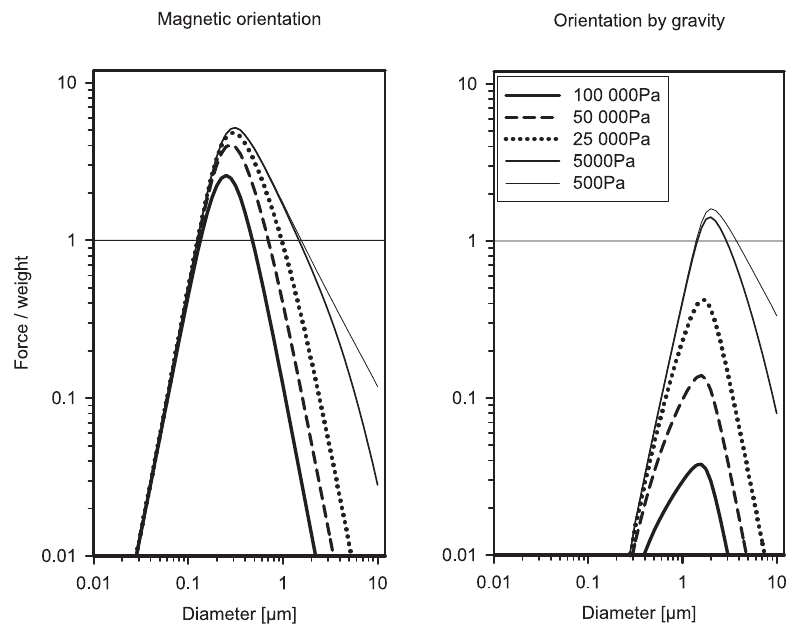
Fig. 10 Relative photophoretic Δ α force: Left: Magnetic orientation of the particle. Right: Orientation by grav- ity. For conditions above the horizontal line, levitation in the atmosphere is possible.